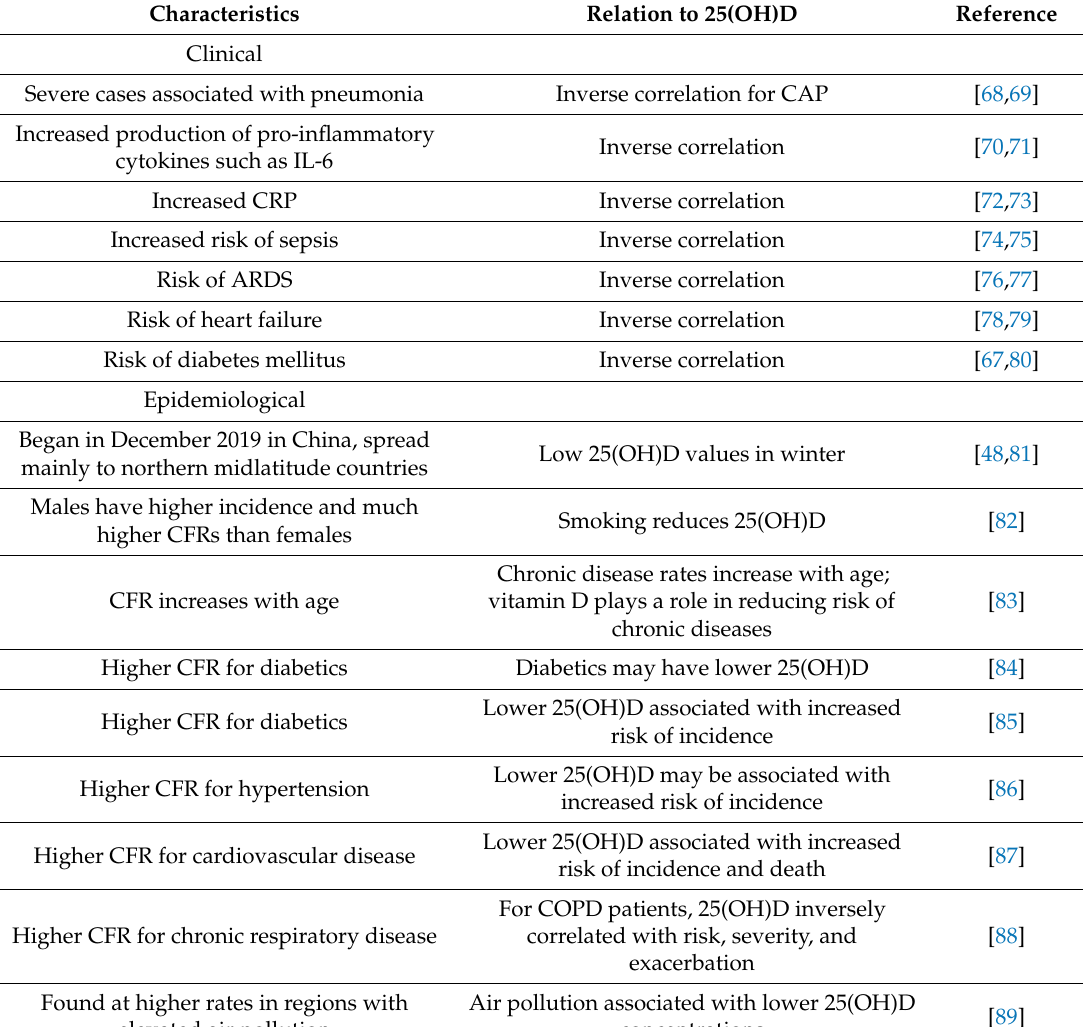
Table 2. How vitamin D is related to the clinical and epidemiological findings for incidence and case-fatality